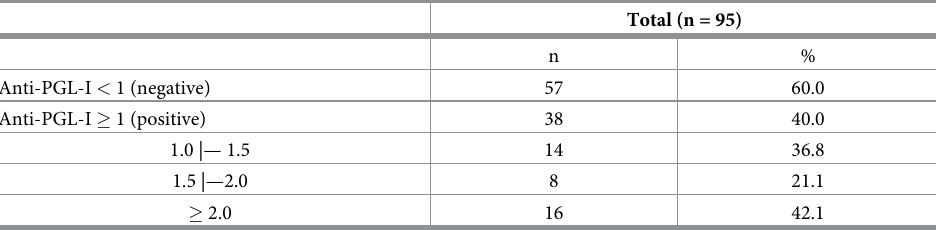
Table 5. Results of anti-PGL-I antibody measurements (anti-PGL-I index; cut off